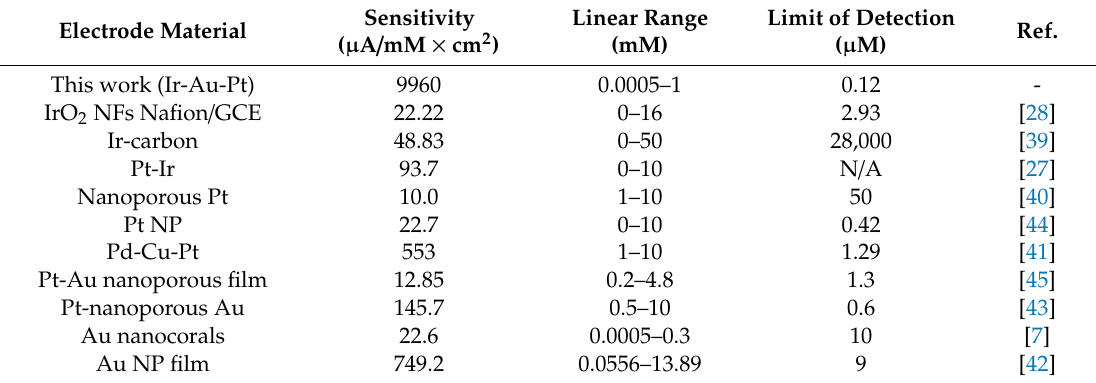
Table 2. Comparison of different electrode materials for non-enzymatic glucose sensing. Electrode